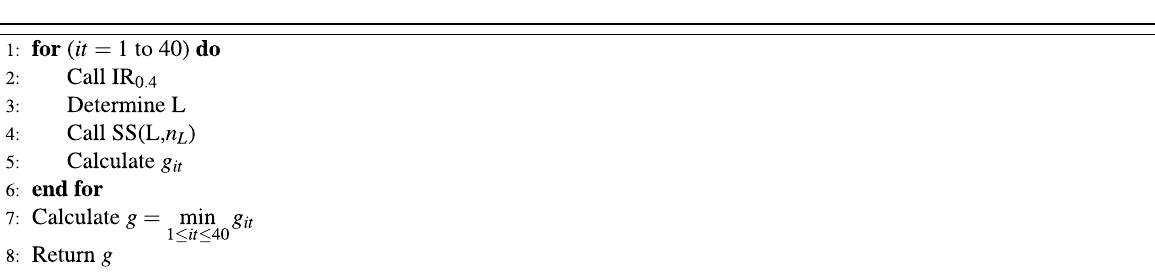
Table 6. Multi-Repeating randomized-NI and subset-sum solution algorithm